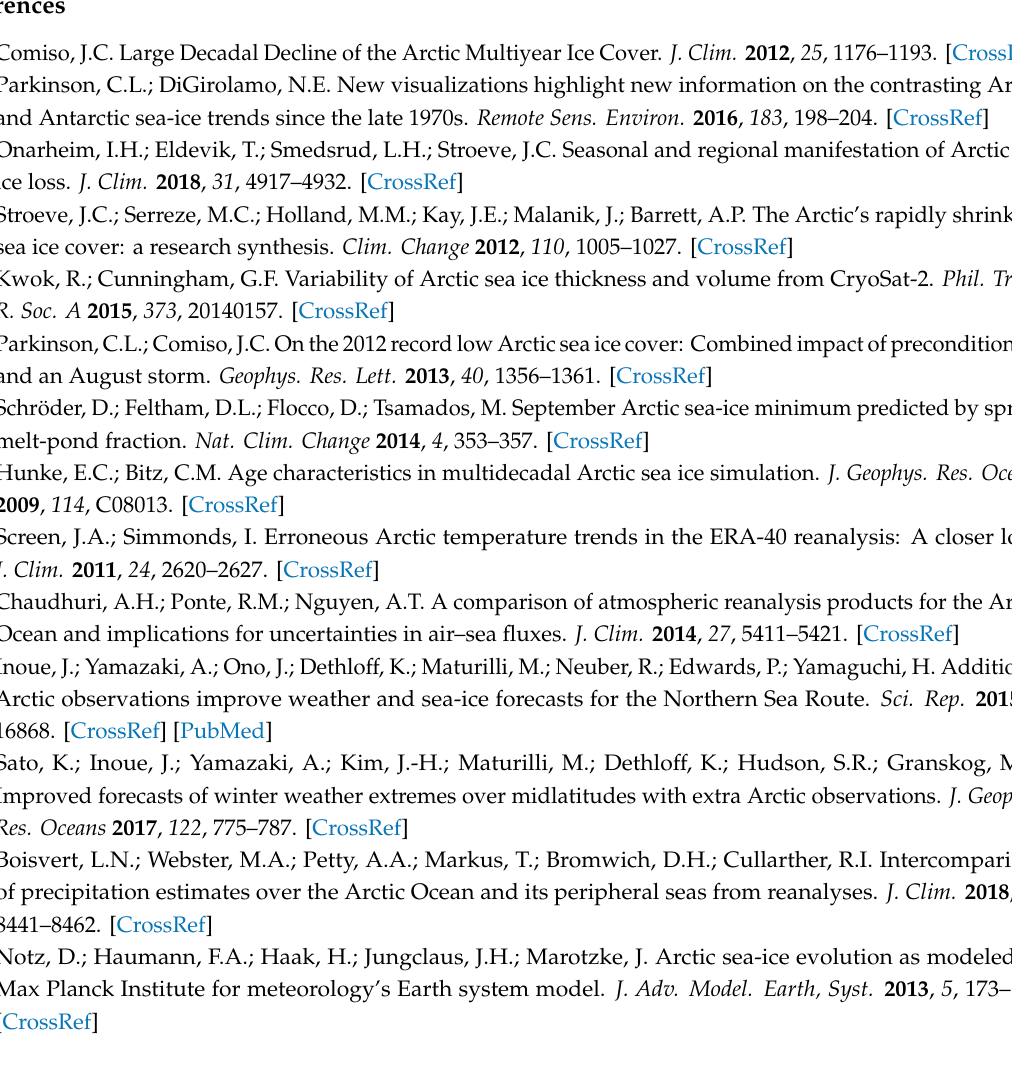
Figure S1: Sea ice volume annual cycles in the Arctic region of ( a ) LW experiments, ( b ) SW experiments, and ( c ) T2m experiments, Figure S2: Sea ice volume annual cycles in the Arctic region of replacing experiments, Figure S3: Taylor diagrams of sea ice volumes in the Arctic